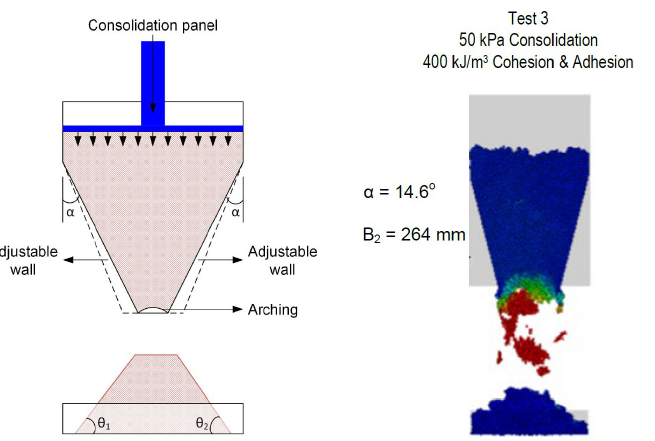
Figure 13. Calibration setup for materials under high consolidation pressure as adapted from [105]. Reproduced with permission from W.